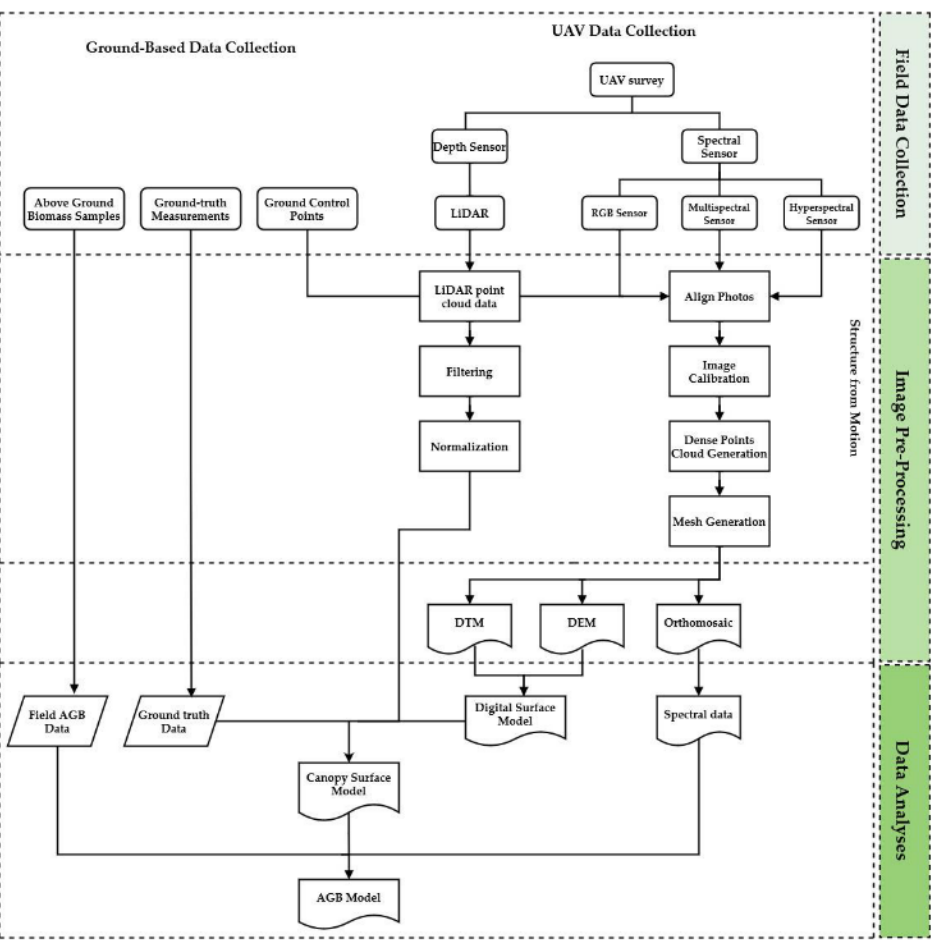
Figure 3. The data processing workflow by which grassland AGB model estimations are generated using Structure from Motion photogrammetry and